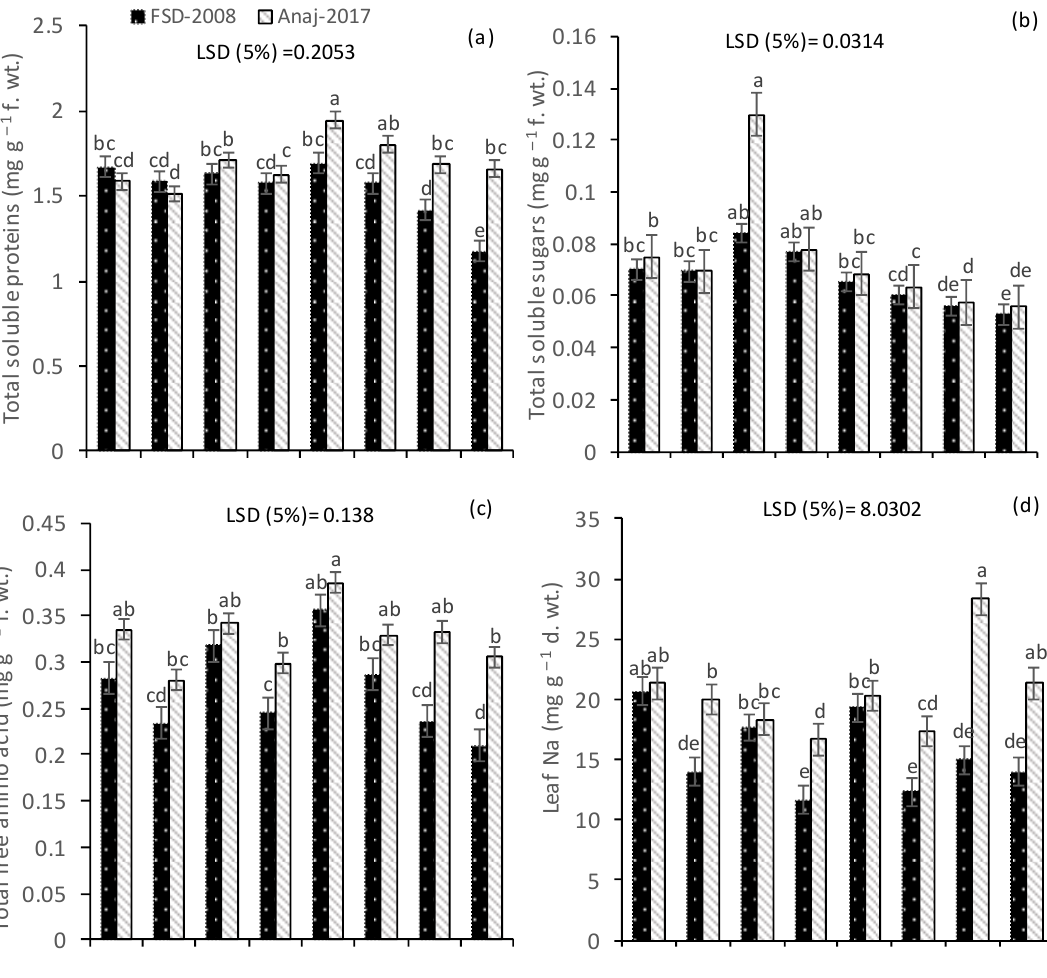
Figure 6. Effects of laser seed priming on ( a ) total soluble proteins, ( b ) total soluble sugars, ( c ) total free amino acids, ( d ) leaf sodium ion, ( e ) leaf potassium ion and ( f ) leaf calcium ion in wheat under drought stress . Legend: N = Control (100% field capacity), D = Drought (50% field capacity), T0 = Unprimed control, T1 = 1 min laser priming, T2 = 2 min laser priming and T3 = 5 min laser priming. Means sharing same lowercase letters on bars are statistically non−significant at P ≤ 0.05%) 3.5. Leaf Ionic